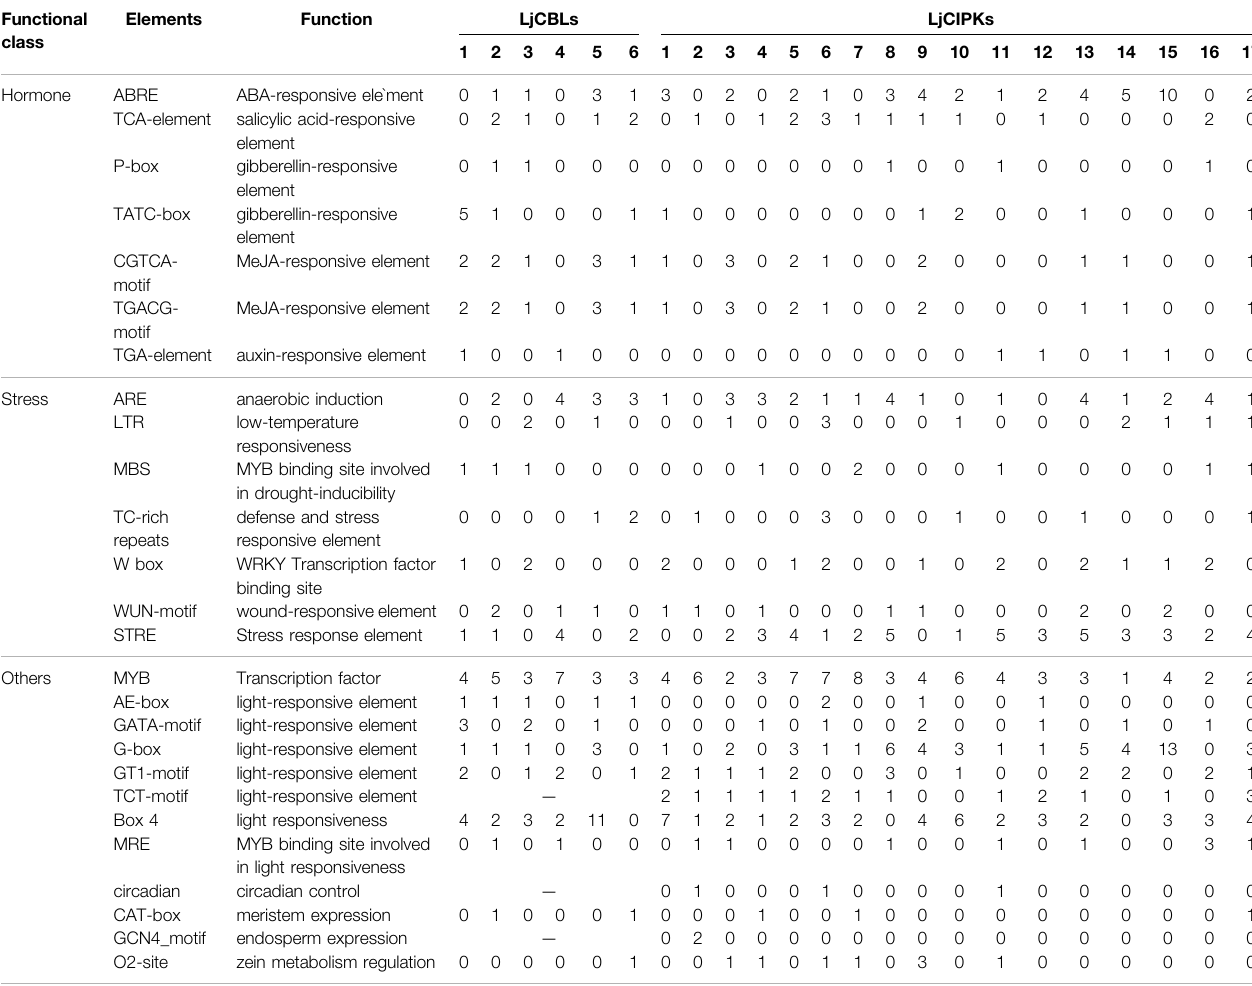
TABLE 2 | Kinds and amounts of hormone-, stress-, and development-related cis-acting element in the promoters of CBL-CIPK genes of honeysuckle. Functional